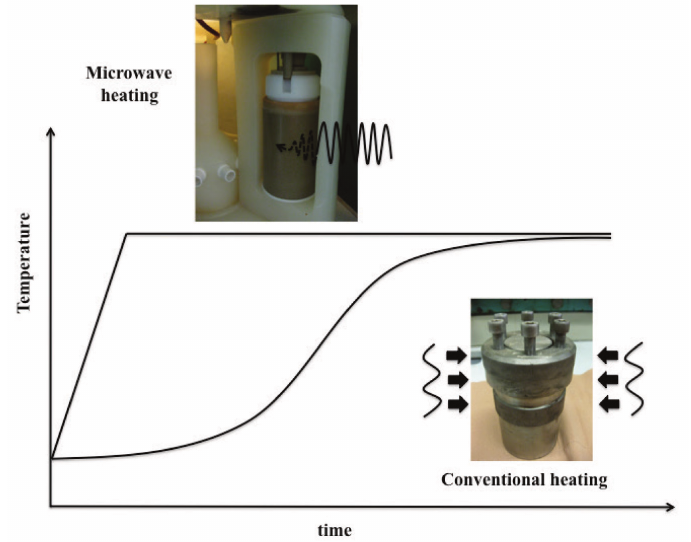
Figure 3. Temperature profiles typical of microwave-assisted and conventionally-heated hydrothermal